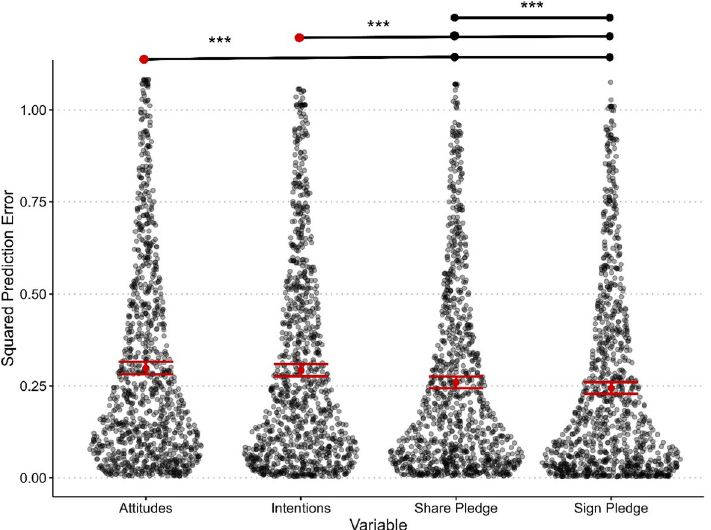
Figure 3. Prediction error across variables. Note : Variables ordered by largest to smallest prediction error (left to right). Black and transparent dots indicate the distribution of individual data points for prediction error across variables. Black dots above the distribution of data points represent variables that show statistically significant differences, whereas red dots above the distribution of data points represent reference variables for comparing statistically significant differences between more than two variables. Error bars represent the 95% confidence interval of the mean. *** p < .001.